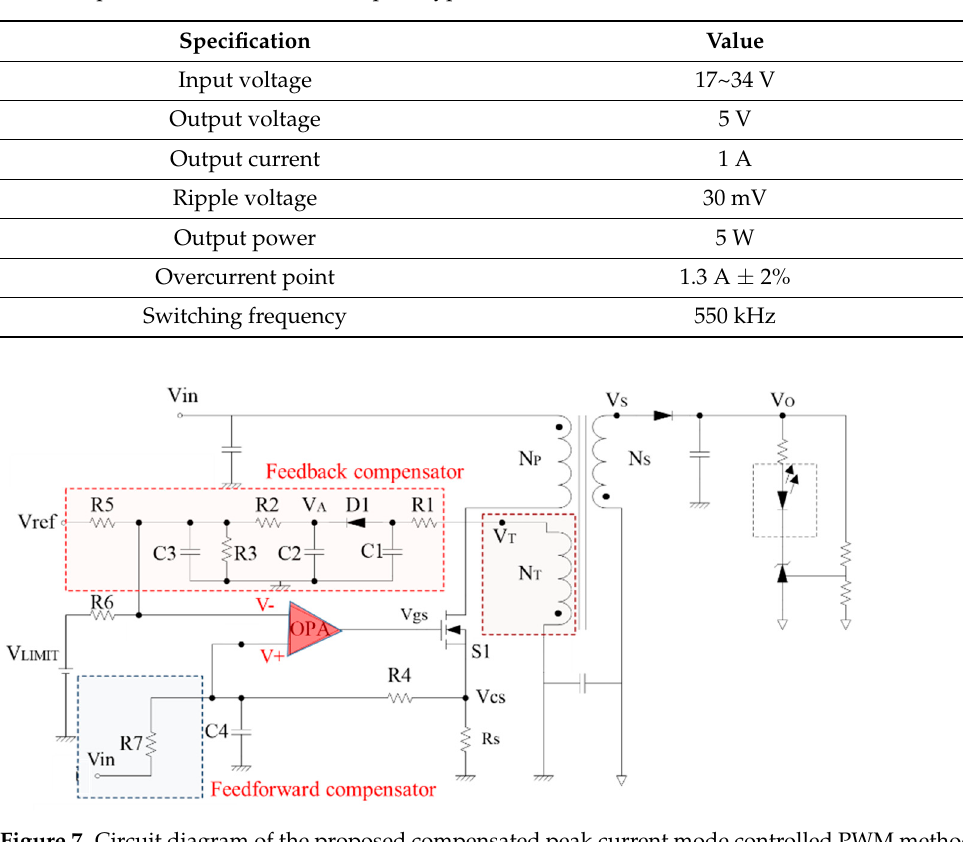
Figure 7. Circuit diagram of the proposed compensated peak current mode controlled PWM method.